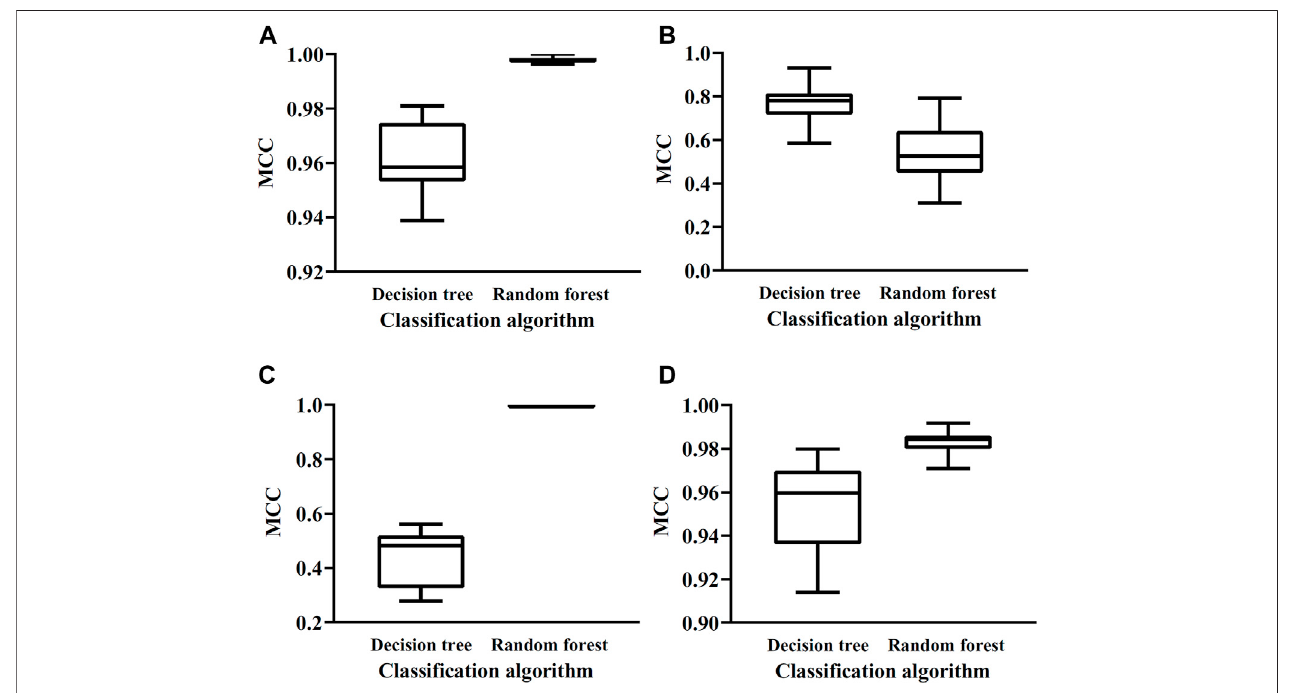
FIGURE4| BoxplotsofMCCvaluesyieldedbyclassi fi erswithrandomlyselectedgenefeatures ondatasetsoffourcerebellumcelltypes. (A) Boxplotsondataset for Granule cells, (B) Box plots on datasets for Granule cells, (C) Box plots on datasets for Interneuron cells, (D) Box plots on datasets for Unipolar brush cells.